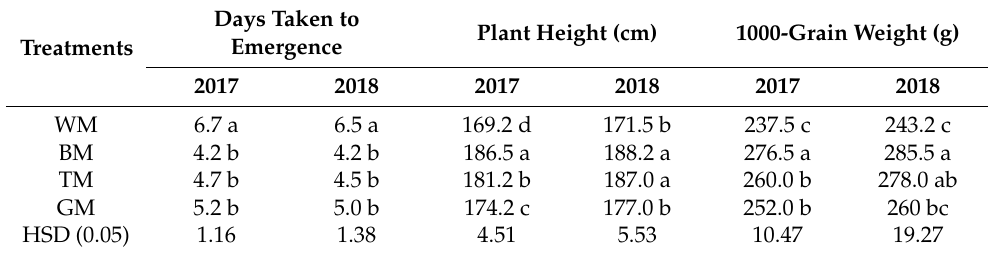
Table 1. Influence of different ridge-furrow mulching on days taken to emergence, plant height (cm) and 1000-grain weight of maize during 2017 and 2018. Days Taken to Plant Height (cm) Emergence Treatments